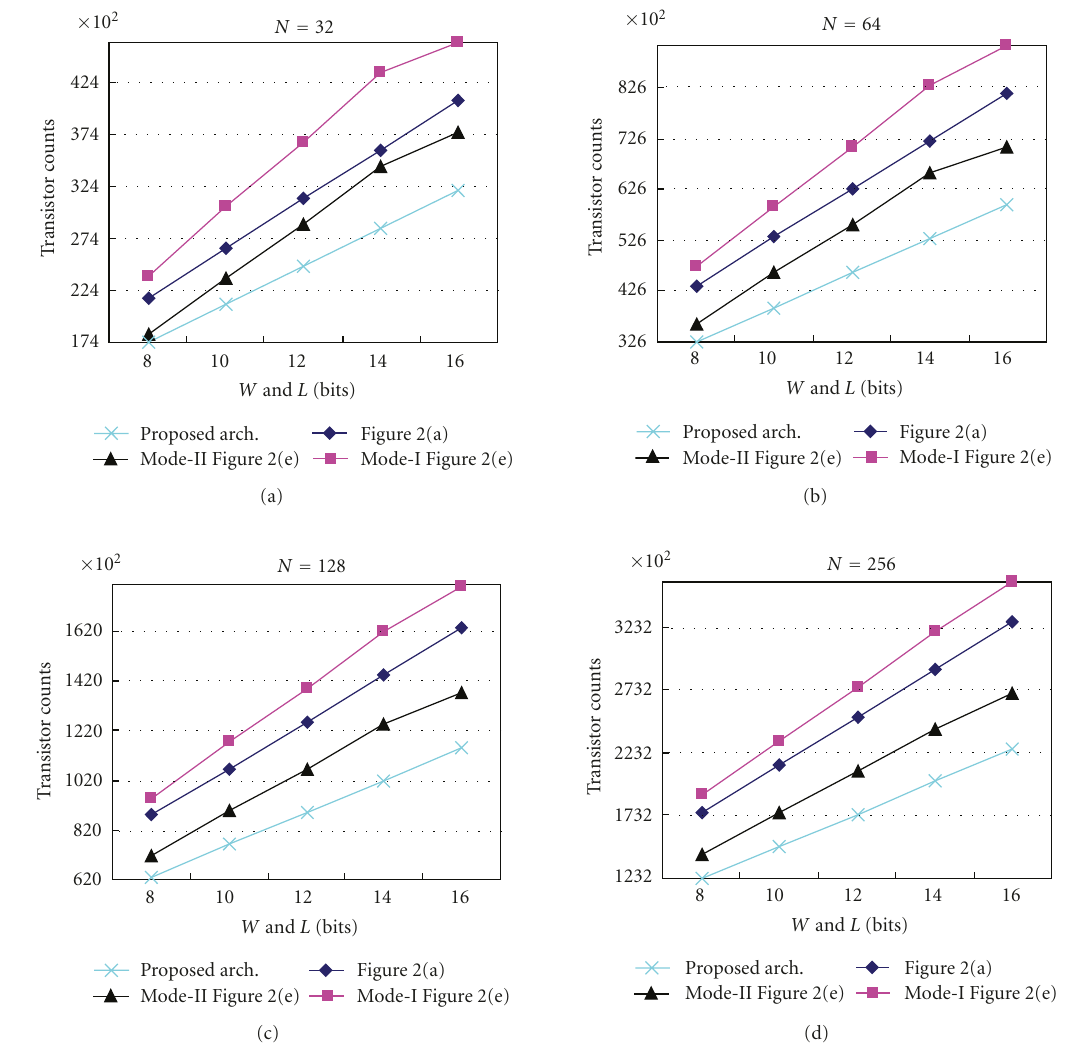
Figure 9: Transistor counts of the proposed architecture and conventional FIR architectures in Figures 2(a) and 2(e).